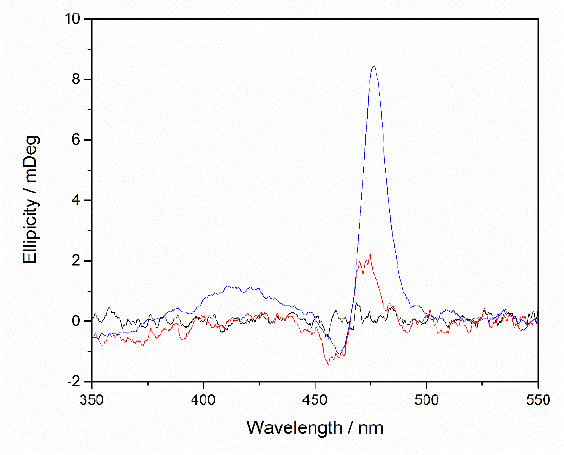
Figure 4. Circular dichroism (CD) spectra of 25 mM HEPES buffer (black), m -MnP2 with 1 eq. of HSA (red), and MnP2 with 1 eq. HSA (blue). Concentrations of MnPs are normalized to 3 μ M.